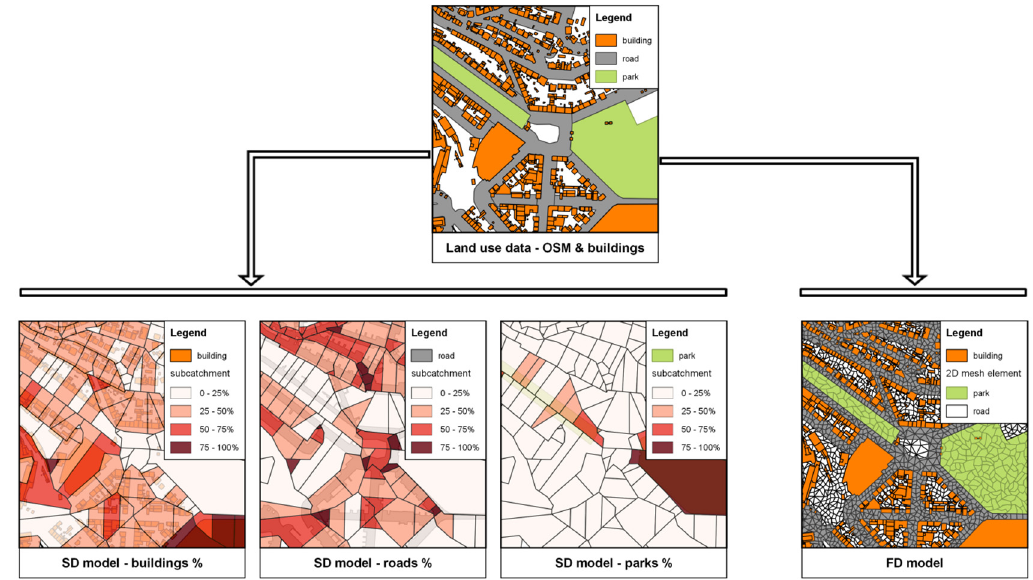
Figure 2. SD (Semi-distributed) and FD (fully distributed) rainfall–runoff land use assignment.